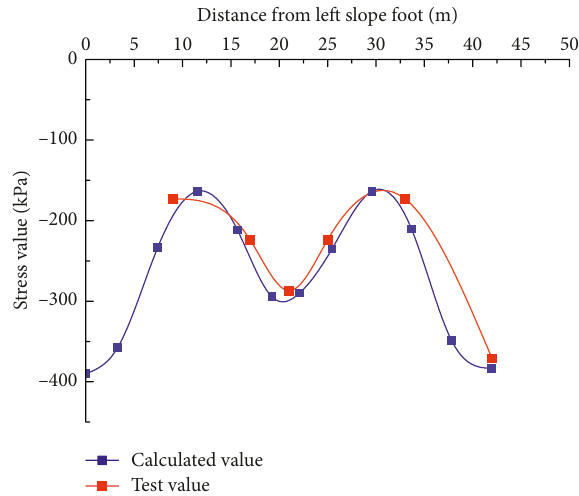
Figure 19: The vertical stress curve of the axis of the base.